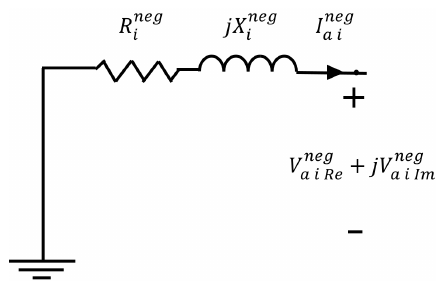
Figure 2. Circuit of the negative sequence for the multimachine generator